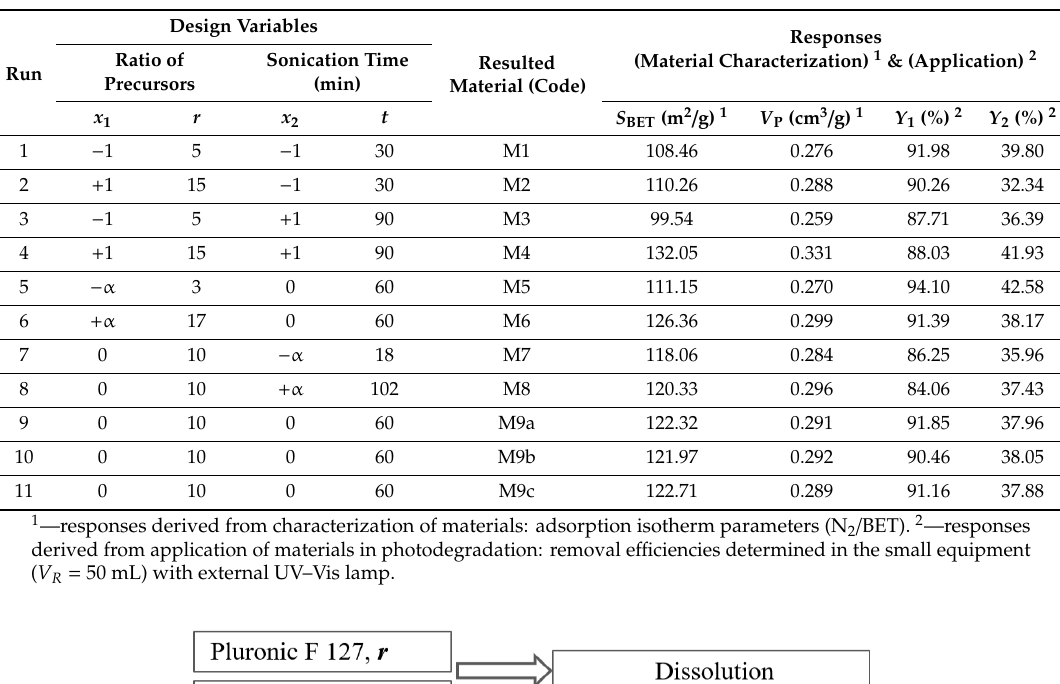
Table 2. Central composite design (rotatable type) used for the experimentation; (materials’ synthesis, characterization and application in photodegradation); α = 1.414.